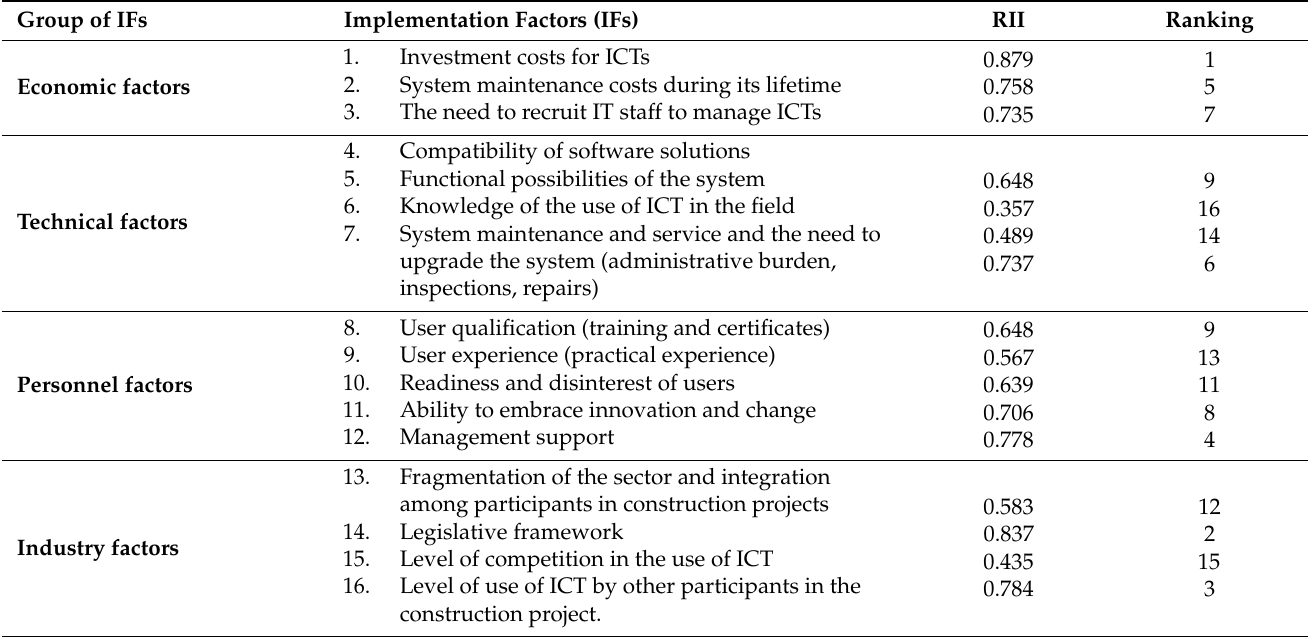
Table 5. Relative importance index of ICT implementation factors in life cycle cost